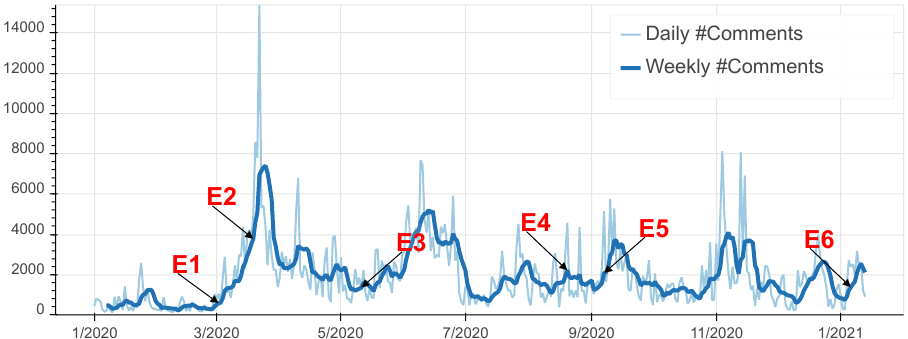
Figure 4. Temporal evolution of COVID-19 related social media communications in Morocco.